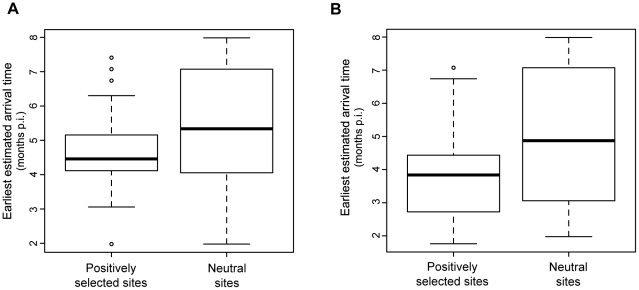
Estimated arrival times of amino-acid substitutions.Amino-acid substitutions were tracked through the whole phylogeny by estimating ancestral sequences at every internal node. The elapsed time since infection and genotypes of these ancestral sequences were then compared to estimate the set of first occurrences in any given lineage (‘arrival times’) for each substitution. (A) Box plot of estimated earliest (minimum) arrival times; (B) Box plot of estimated latest (maximum) arrival times. Sites with p (dN/dS>1)≤0.05 (see Methods) were categorised as ‘positively-selected.’ Substitutions at other sites were therefore assumed to have occurred neutrally.